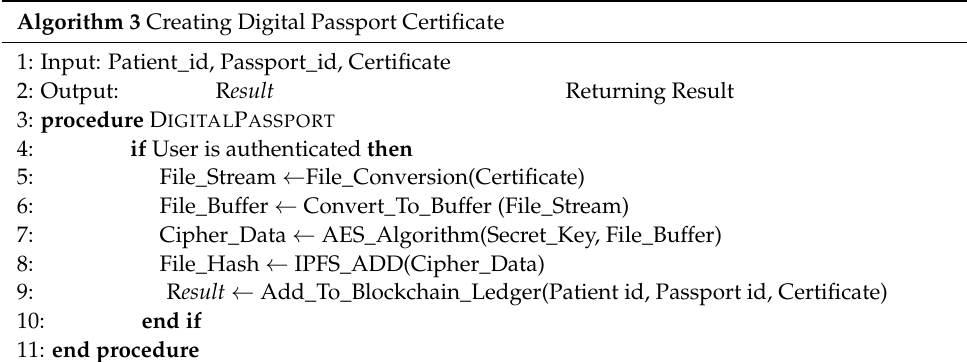
Algorithm 3 Creating Digital Passport Certificate